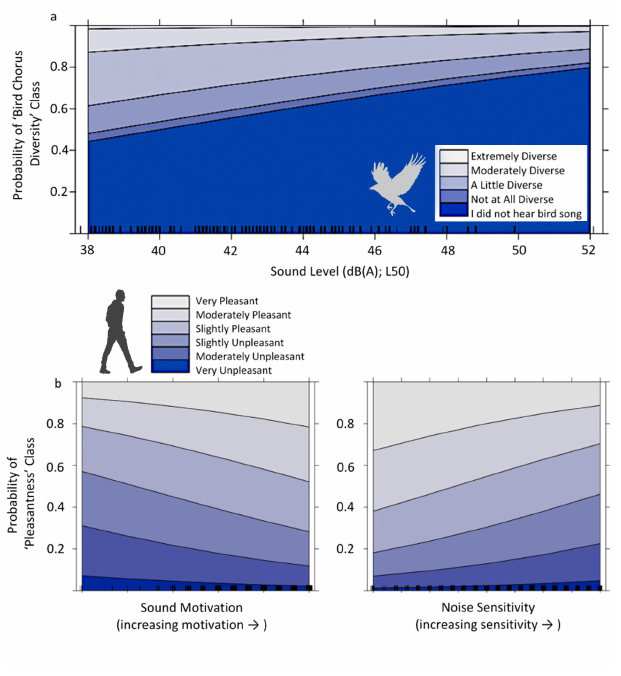
Fig. 3 . Comparison of marginal utility coefficients